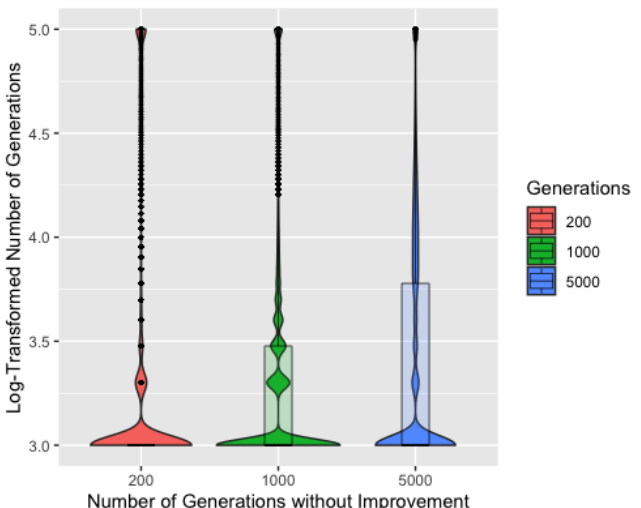
Figure 5. Boxplots and violin plots for log (base 10) number of generations to solution by number of generations without improvement. The absence of a box for 200 generations without improvement indicates that the median, first quartile, and third quartile are the